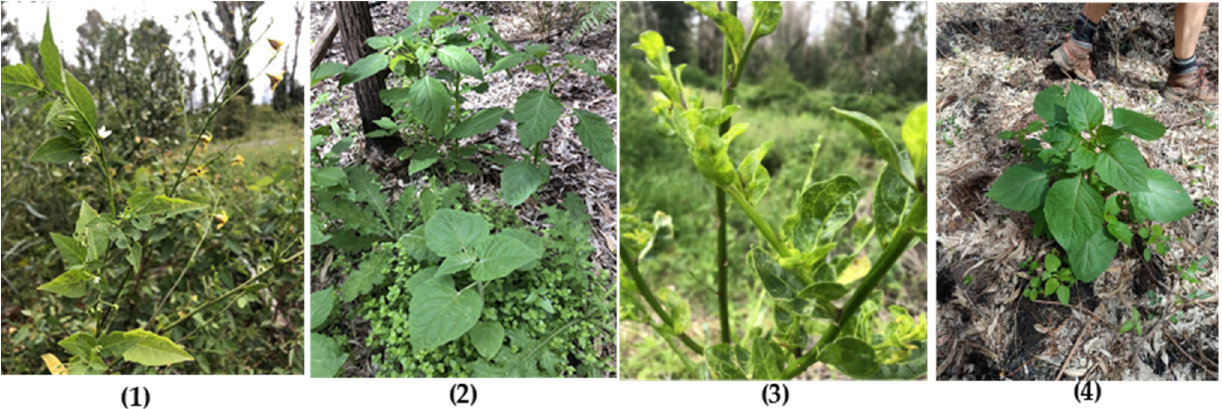
Figure 2. YTMMV-infected plants in the wild. ( 1 ) Anthocercis illicifolia (yellow flowers) and Solanum nigrum (white flowers) flowering adjacent to one another at Yanchep; ( 2 ) Infected Physalis peruviana (foreground) and S. nigrum (rear) plants growing adjacent to one another at Yanchep; ( 3 ) Leaf mosaic, distortion, and chlorosis on YTMMV-infected A. illicifolia plant at Yanchep. ( 4 ) Asymptomatic YTMMV ‐ infected S. nigrum plants at the Bertram site.